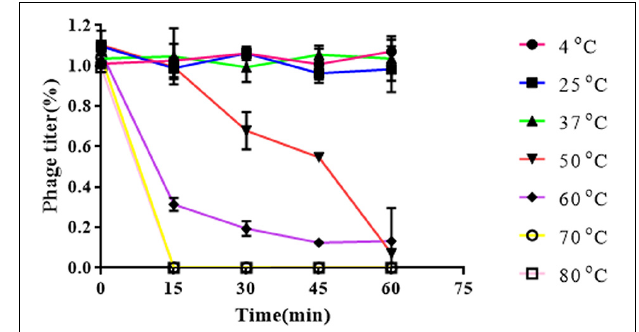
FIGURE 5 | Thermal stability of phage vB_EaeM_ ϕ Eap-3. Each data point represents the mean of three independent experiments. Results were expressed as PFU/mL.